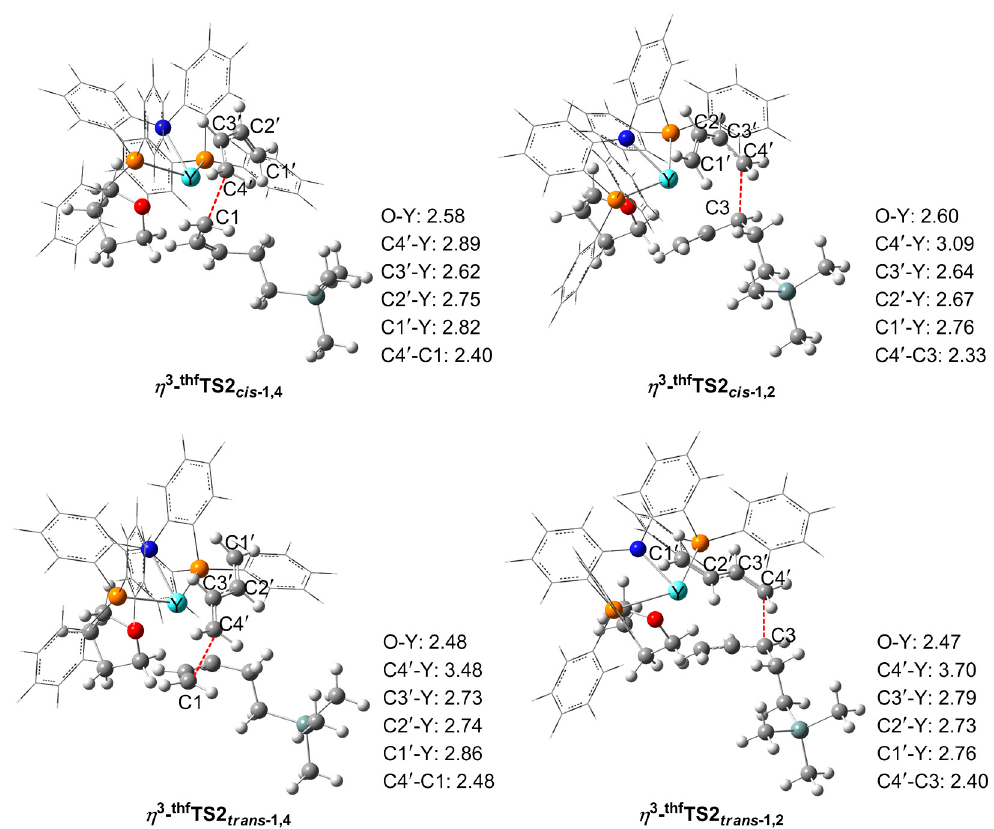
Figure 4. Transition state structures (distances in Å) for the cis - and trans -insertions of butadiene into the Y–allyl π -bond of the thf P1 cis .